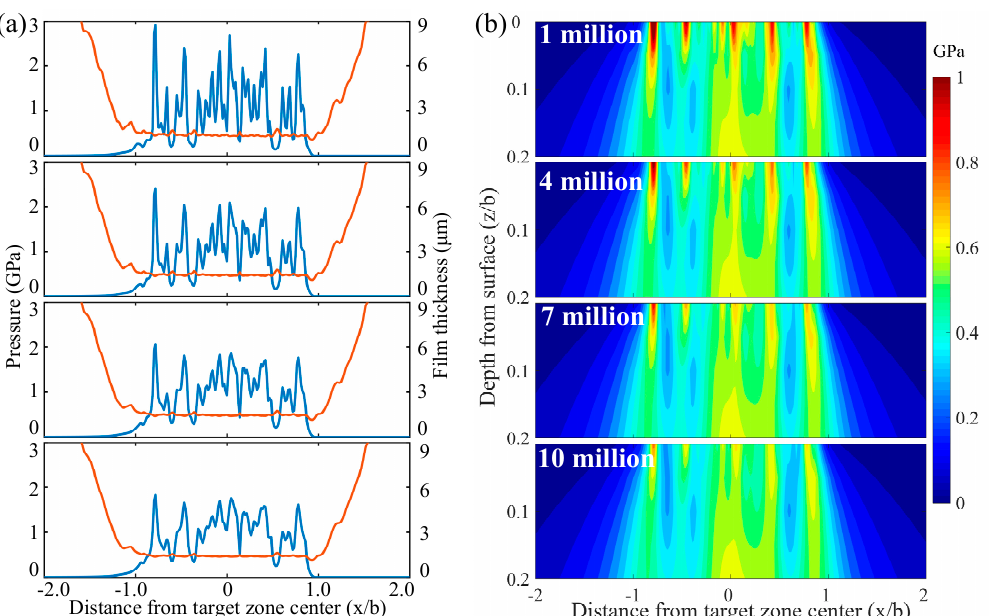
Figure 11. The distributions of ( a ) pressure, film thickness and ( b ) von Mises stress during 10 million cycles.